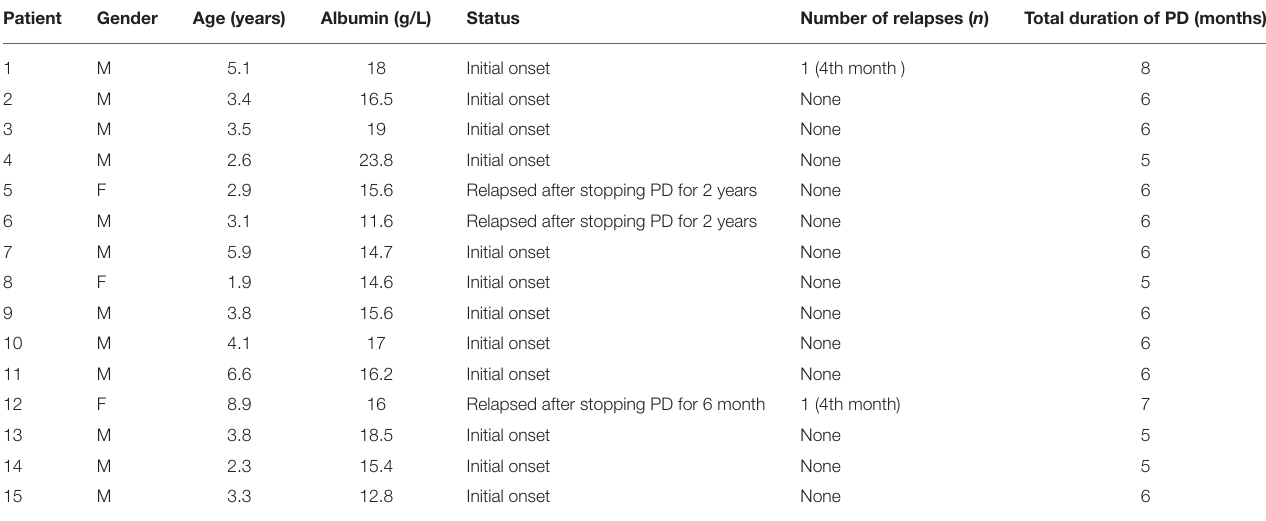
TABLE 1 | Demographic and clinical characteristics of the patients.